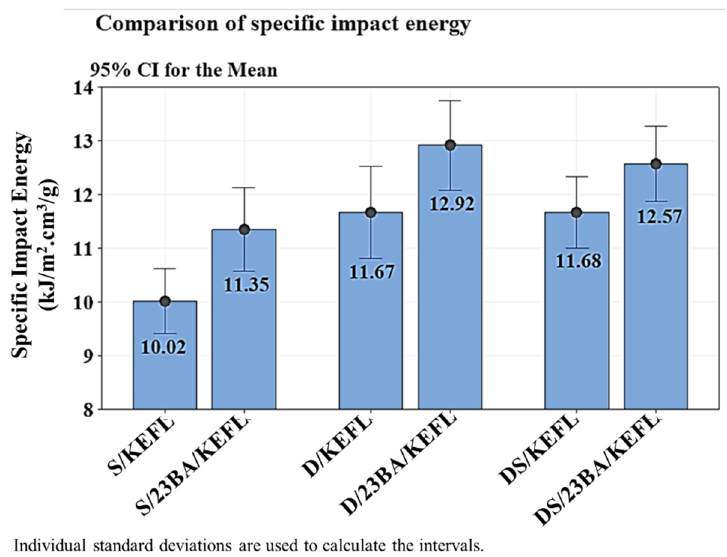
Figure 10. Comparison of specific impact energy of bast fiber composites with hybrid composites.